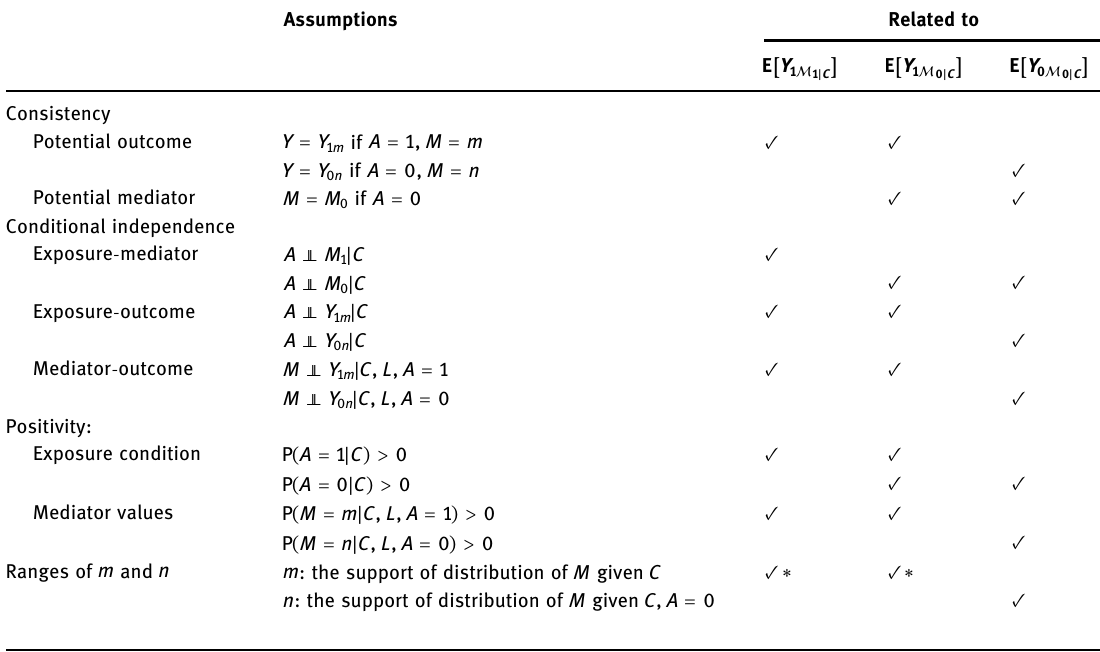
Table 6: Identifying assumptions for Y Assumptions Related to